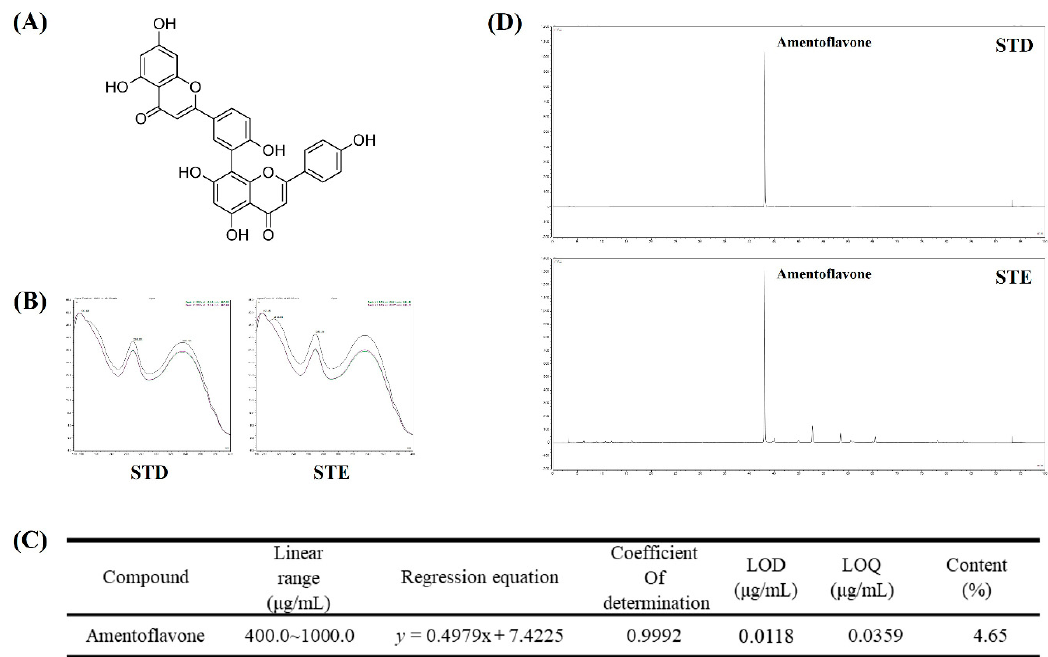
Figure 8. HPLC chromatogram of Selaginella tamariscina ethanol extract (STE). ( A ) Chemical structure of amentoflavone. ( B ) UV spectra of standard compound of amentoflavone and STE. ( C ) Regression equations, limit of detection, and limit of quantitation of amentoflavone. ( D ) HPLC chromatogram of amentoflavone standard solution and STE. STD, standard; LOD, limit of detection; LOQ, limit of quantitation.